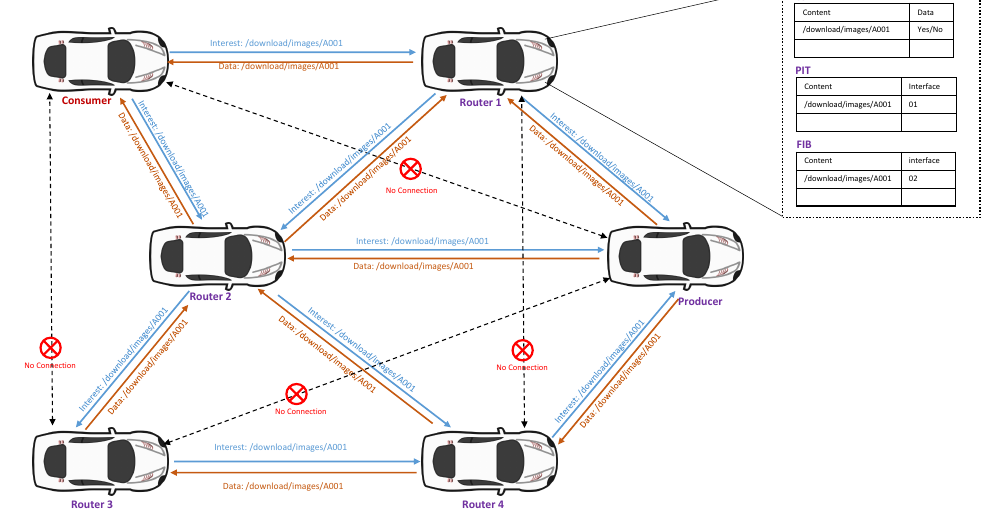
Figure 1. VNDN data forwarding